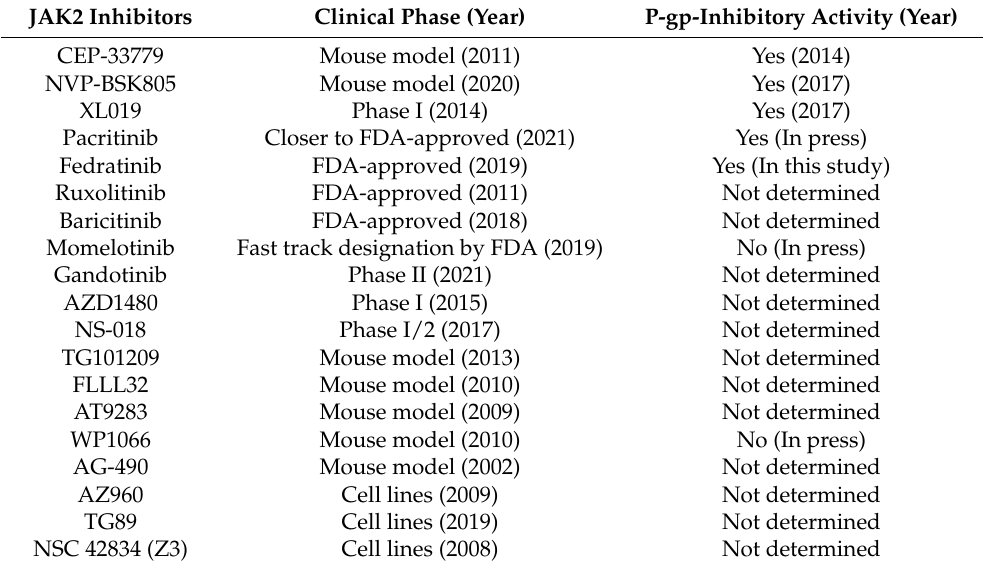
Table 1. JAK2 inhibitors and their P-gp inhibitory